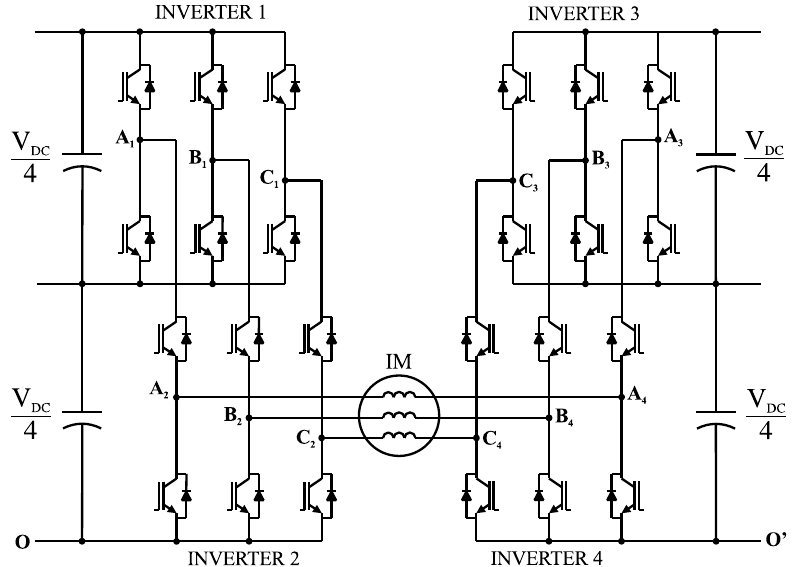
Figure 1. Medium-voltage open-end winding induction motor drive.